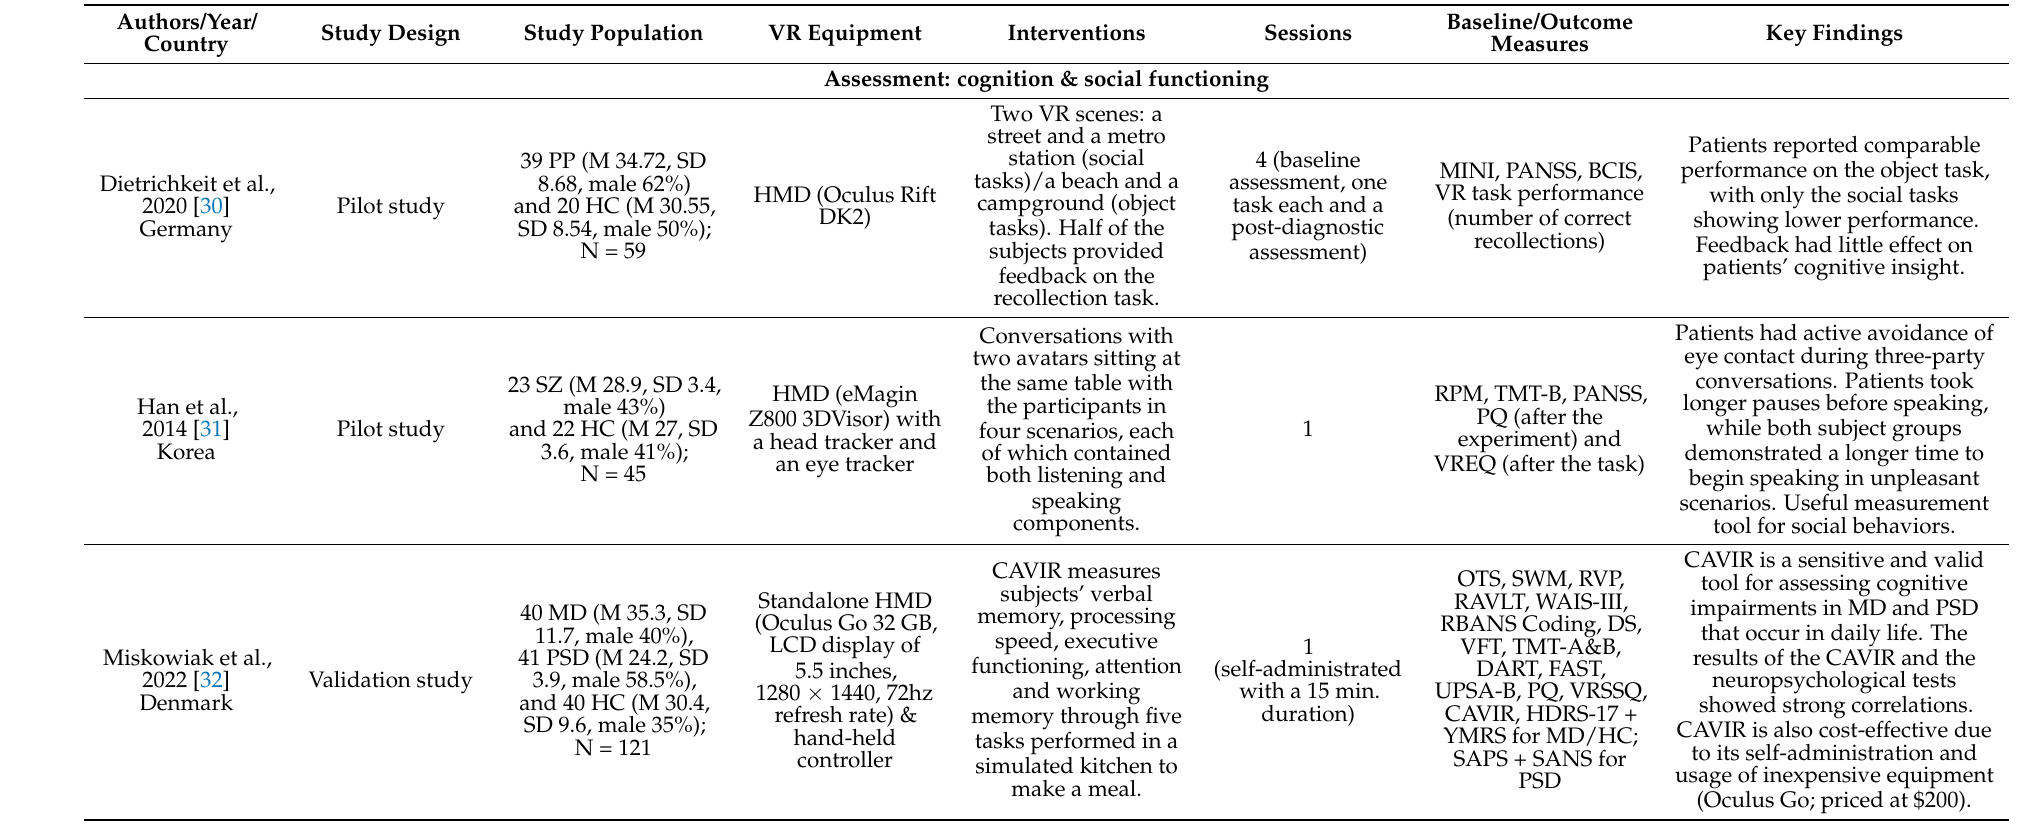
Table 1. Studies on VR-based assessment and